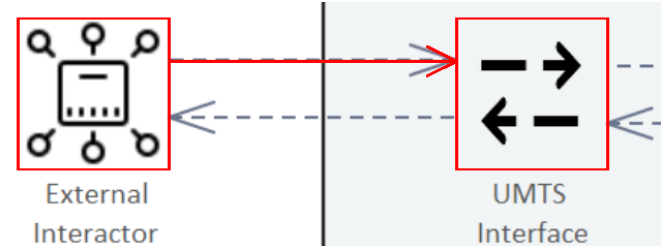
Figure 15. Threat over cellular